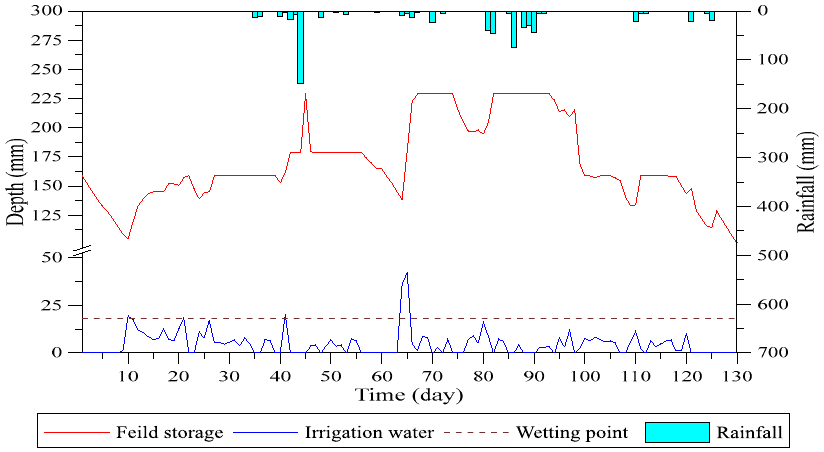
Figure 19. Simulation of block 5 under 30% reduction of planned irrigation water during the first crop season.